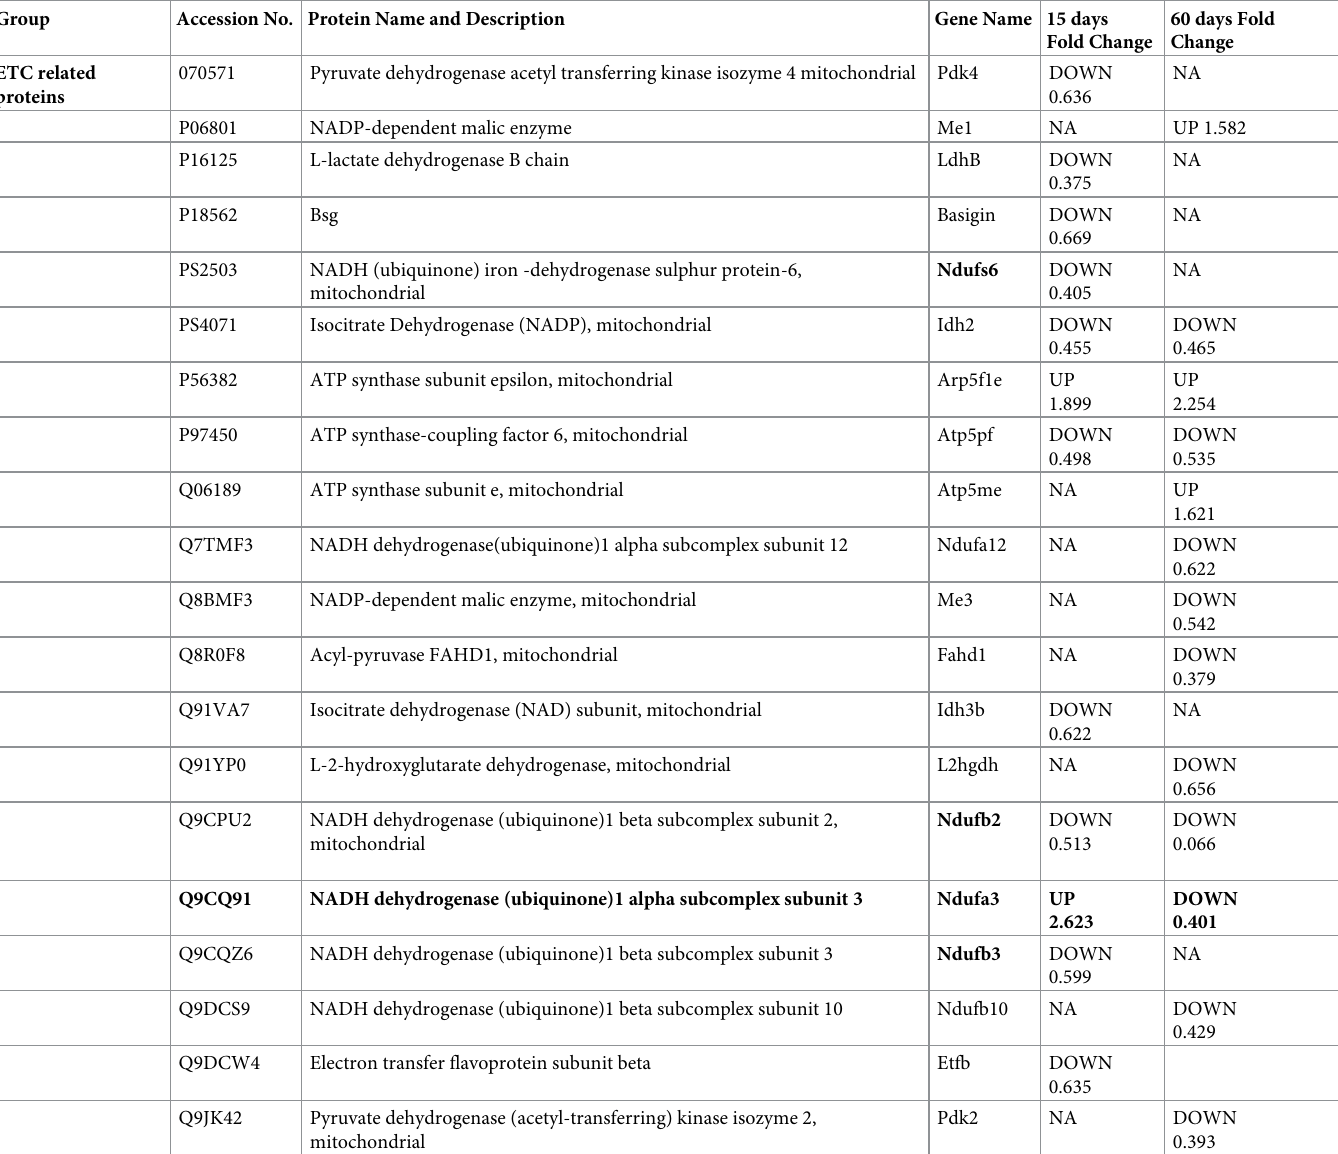
Table 1. Summarizes the proteins involved in network analysis (Fig 2), when the NaF dose of 80ppm was administered for 15 and 60 days, a reduction in enzymes involved in energetic pathways (ETC) was observed.